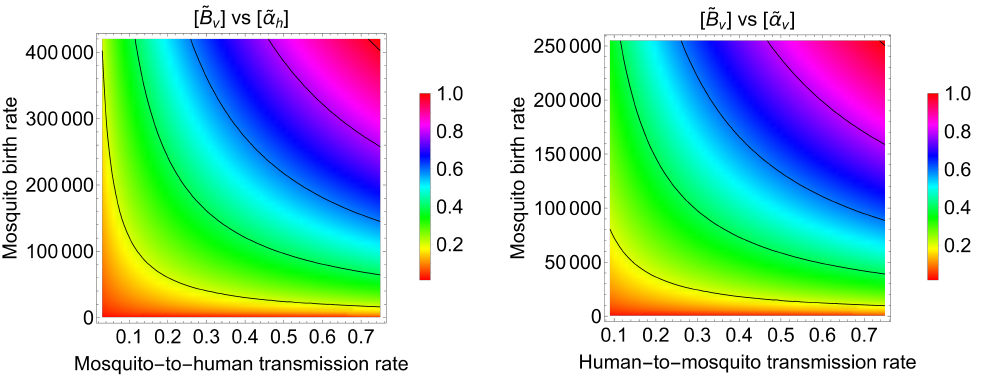
] and one of the three controllable parameters: v ] ) and human-to-mosquito transmission rate ( [ ˜ α h